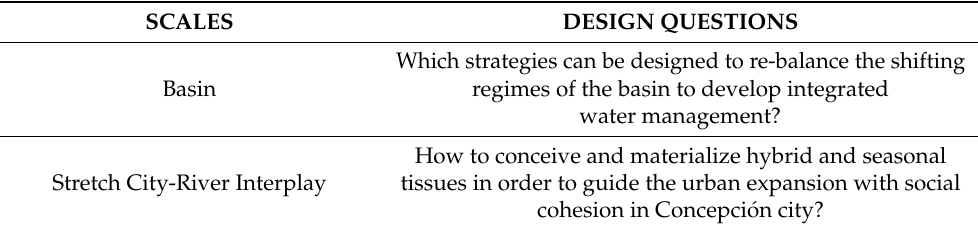
Table 1. Design questions proposed in the International Design Competition, Concepción Living at (in) the Edge . Source: By the author Espinosa [52].